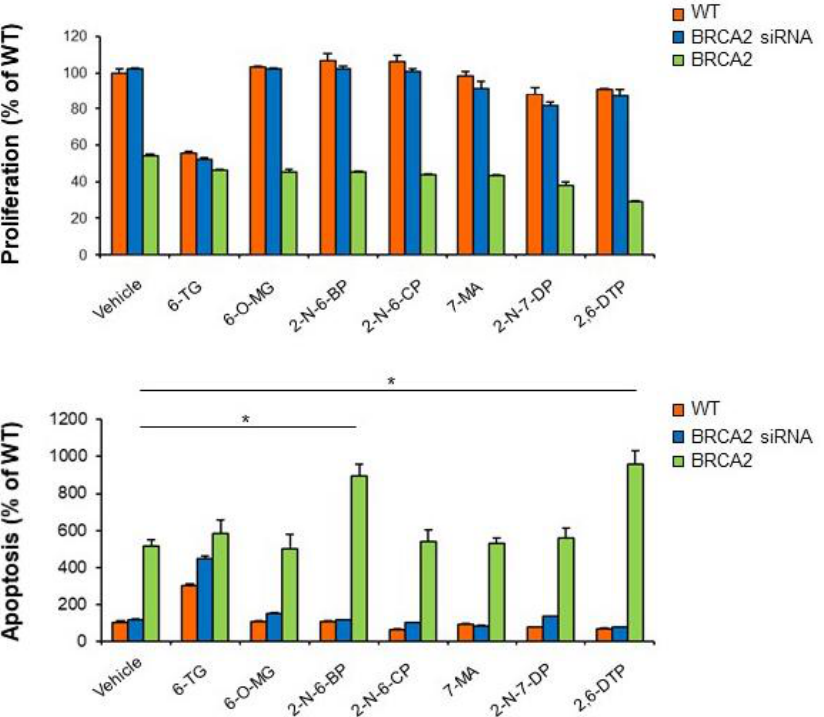
Figure 7. BRCA2 expression confers sensitivity to 2-N-6-BP and 2,6-DTP in castration-resistant prostate cancer cells. C-4 cells were transiently transfected with BRCA2 siRNA, a non-targeting siRNA (CTRL) or with recombinant BRCA2 cDNA. Twenty-four hours after transfection the cells were treated with 5 µ M 6-TG, 6-O-MG, 2-N-6-BP, 2-N-6-CP, 7-MA, 2-N-7-DP, 2,6-DTP or solvent alone ( − ). Forty-eight hours after treatment, cell proliferation and apoptosis were measured by XTT (top panel) and Cell Death Detection (bottom panel) assay, respectively. Each point represents the mean ± SD from cells of triplicate wells. The experiment was repeated two times. * p < 0.01.